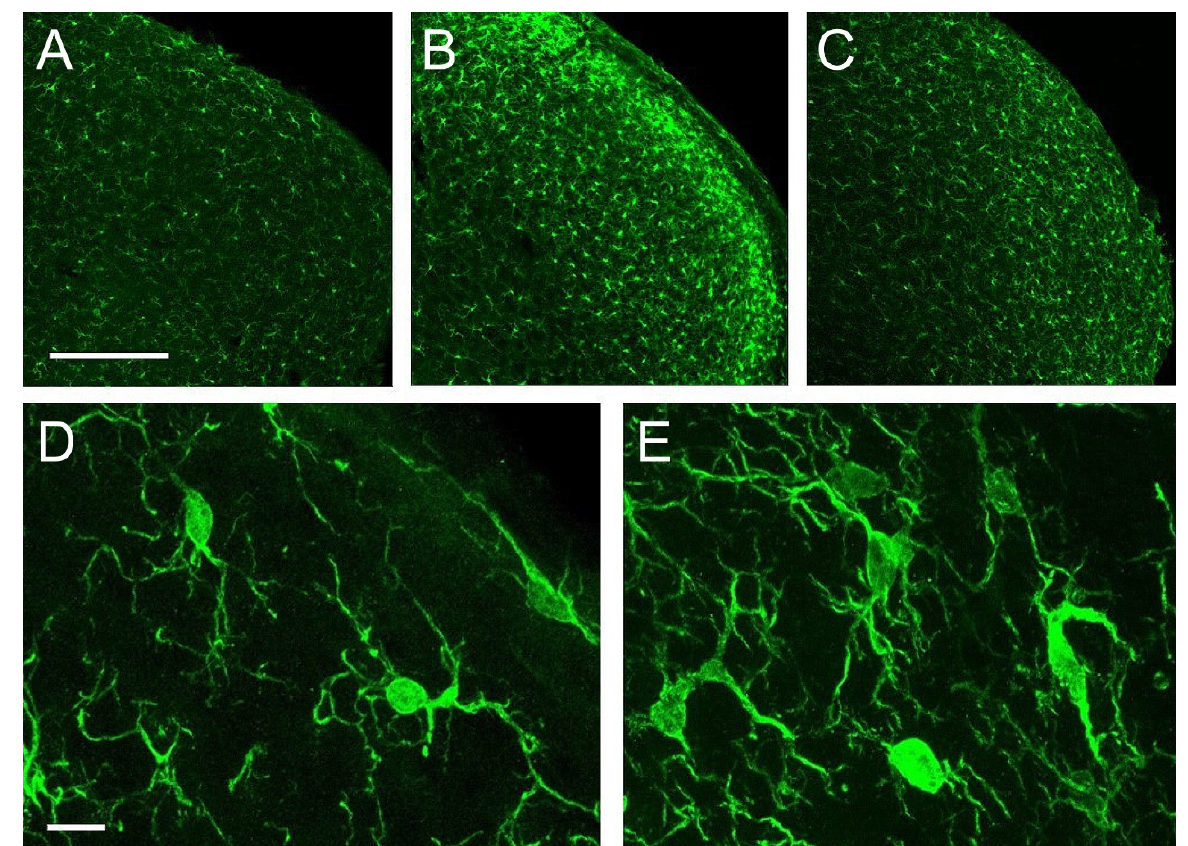
Figure 5. Confocal images of coronal sections of the trigeminocervical complex (TCC) at a caudal level of Sp5C immuno- labeled for Iba-1. In controls ( A , D ) microglial cells showed a homogeneous distribution, relative low density, and a typical morphology of a ‘resting’ or ‘surveying’ state. CCI-IoN induced a potent microgliosis at 5 dpo ( B ), which decreased but still persisted at 21 dpo ( C ). Activated microglia ( E ) was typically characterized by an increase in the number of cells, which exhibit heterogeneous shapes and sizes, predominating those with larger and irregular somata, and an increased number of processes, including thicker protoplasmic expansions. Scale bars = 500 µm ( A – C ) and 10 µm ( D , E ).